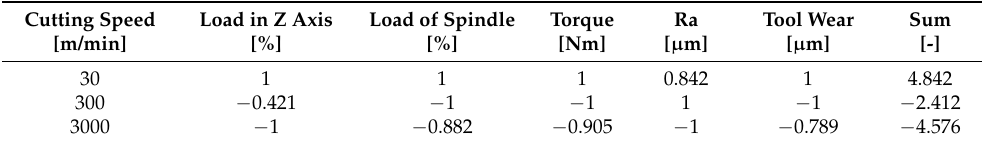
Table 11. Linear transformation of cutting speed influence on observed parameters during machining zirconia.